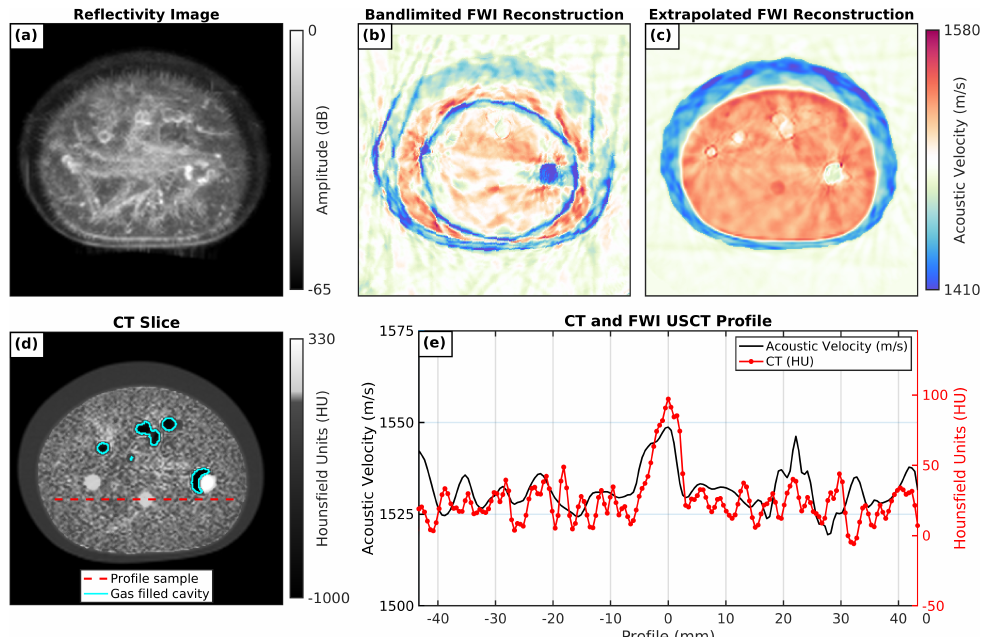
Figure 7. Results from imaging a cross-sectional slice of the CIRS breast phantom. ( a ) Reflectivity image with full-angle spatial-compound technique with refraction correction and 65 dB dynamic range; ( b ) full-waveform inversion reconstruction using using narrow-band data; ( c ) full-waveform inversion reconstruction using using low-frequency extrapolated data; ( d ) CT with gas-filled cavities highlighted in cyan; ( e ) profile of CT and FWI USCT along the phantom in a region with a uniform background and a central area with higher